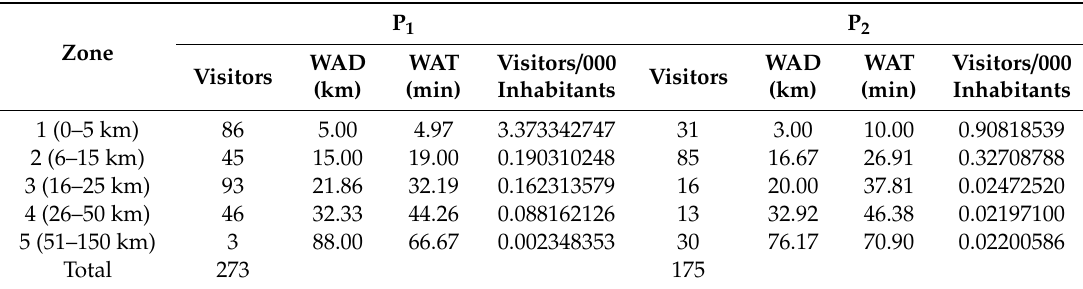
Table 4. Weighted Average Distance (WAD) and Weighted Average Time (WAT) taken by visitors of SPNP for both periods.